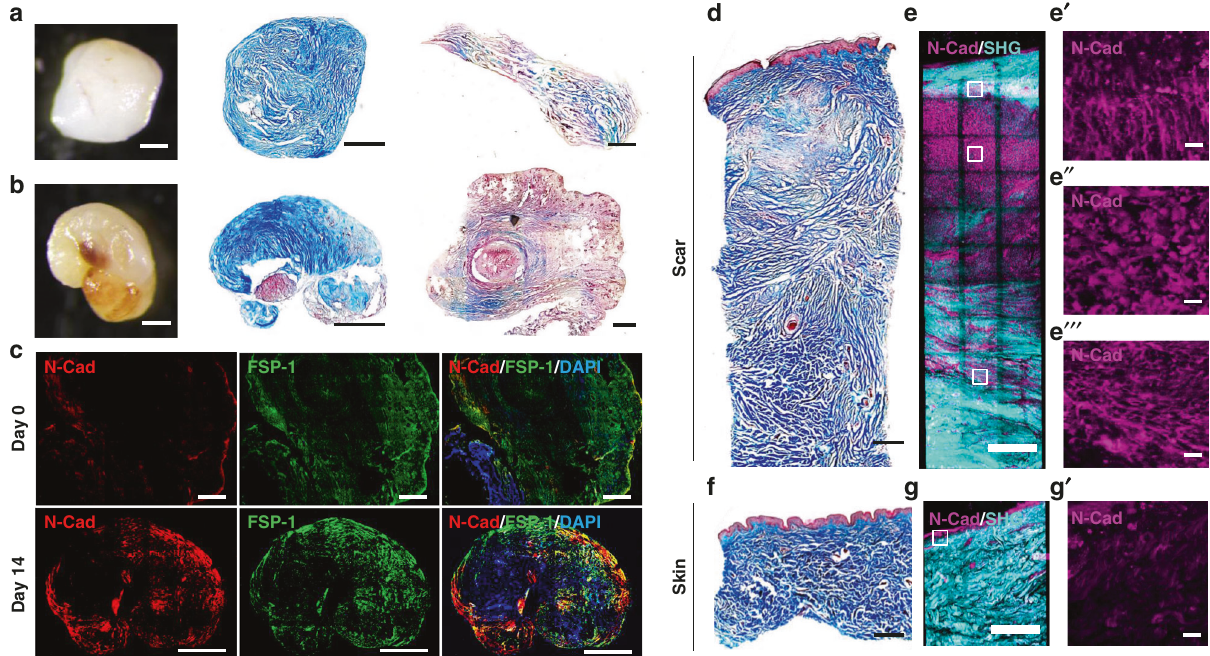
Fig. 6 N-cadherin is involved in scar formation in human skin. a , b whole-mount bright- fi eld image and Masson ’ s trichrome staining of SCADs made from human eyelid skin ( a ) or thigh skin ( b ) 14 days after culture (middle). The histology of respective fresh SCADs is shown in right column. n > 100. c Immunolabelling of N-cadherin (red) and FSP1 (green) of human SCAD at day 0 and day 14. d – g Masson ’ s trichrome staining and 3D immunostaining of N-cadherin on biopsy from human breast hypertrophic scar ( d, e ) or adjacent breast skin ( f, g ). N-cadherin (magenta), SHG (cyan). The enlarged images of the N-cadherin channel indicated by white boxes in e , g are shown in e ′ , e ″ , e ″′ and g ′ , respectively. Scale bars = 500 µ m, except e ′ – e ″′ , g ′ = 20 µ m.